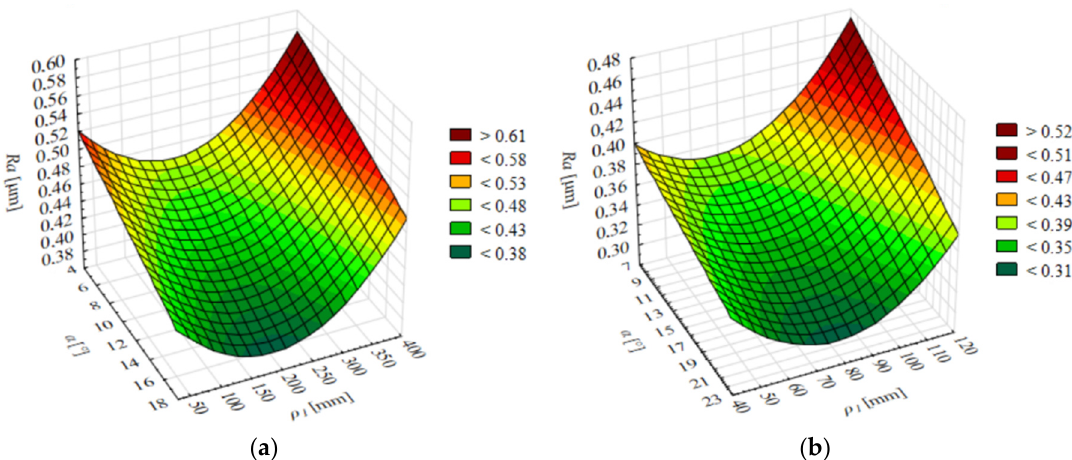
Figure 10. Influence of the lead angle α and radius of curvature ρ 1 on the Ra roughness parameter of the convex ( a ) and concave ( b ) surface.